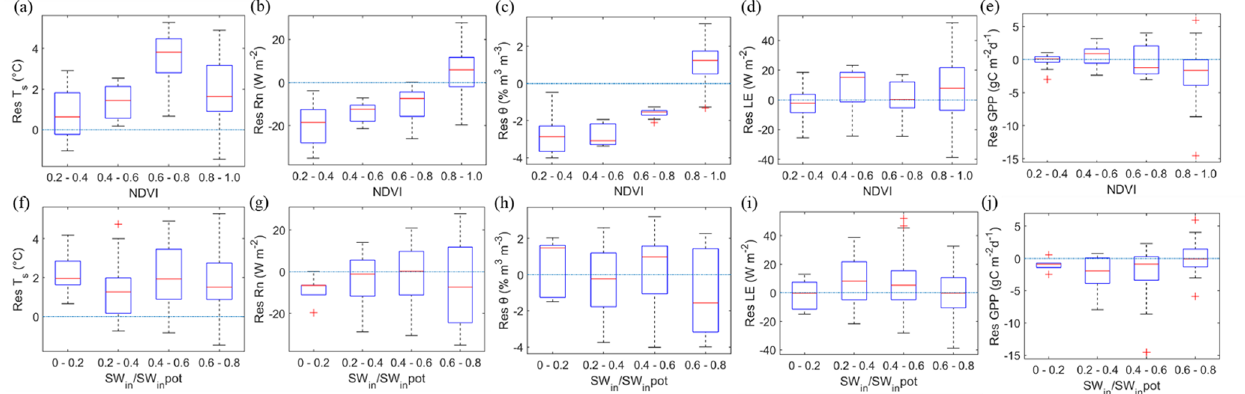
Figure 7. Boxplots of the residuals for the daily simulation. Panels (a–e) show the simulation residuals and NDVI. Panels (f–j) show simu- lation residuals and the ratio of the actual (SW in ) and potential (SW in , pot ) solar radiation, which is an indicator of the cloudiness condition. Panels (a) and (f) show the surface temperature ( T s ); (b) and (g) show the net radiation ( R n ); (c) and (h) show the soil moisture ( θ ); (d) and (i) show the latent heat flux ( LE ); and (e) and (j) show the gross primary productivity (GPP). The blue dashed lines refer to the zero residuals.